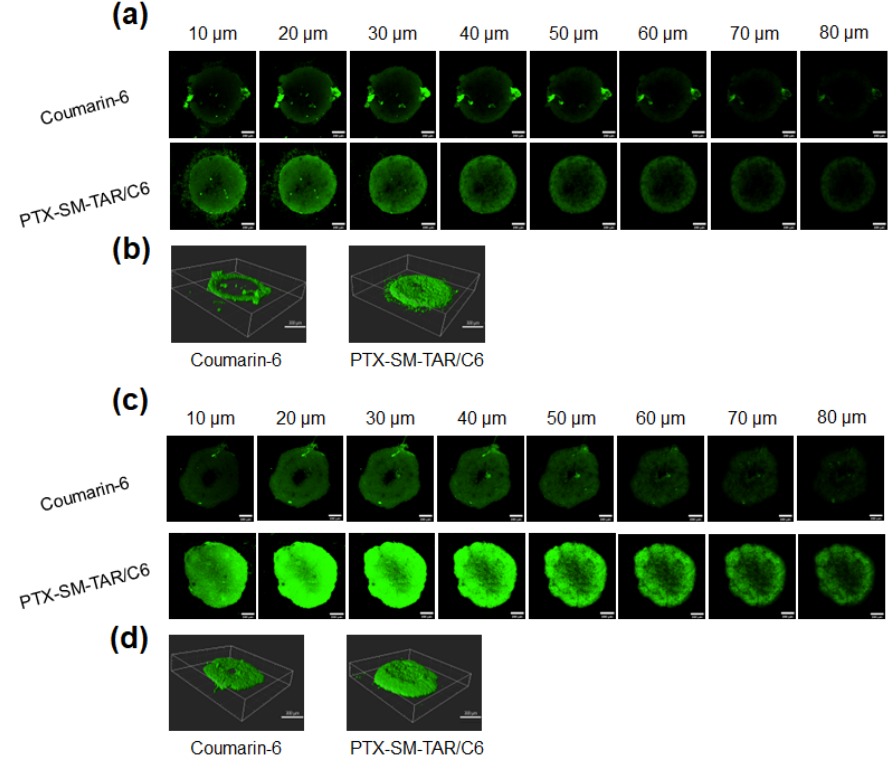
Figure 7. Penetration of PTX-SM-TAR NPs in 4T1-mCherry-Luc 3D tumor spheroids. ( a , c ) Scanned images of tumor spheroids treated with PTX-SM-TAR/C6 NPs and coumarin-6 for 2 and 4 h, re- spectively. Green, coumarin-6. The scale bar is 200 μ m, the interval is 10 μ m. ( b , d ) 3D-reconstruction of tumor spheroids in PTX-SM-TAR/C6 NPs and coumarin-6 for 2 and 4 h, respectively. The scale bar is 300 μ m.